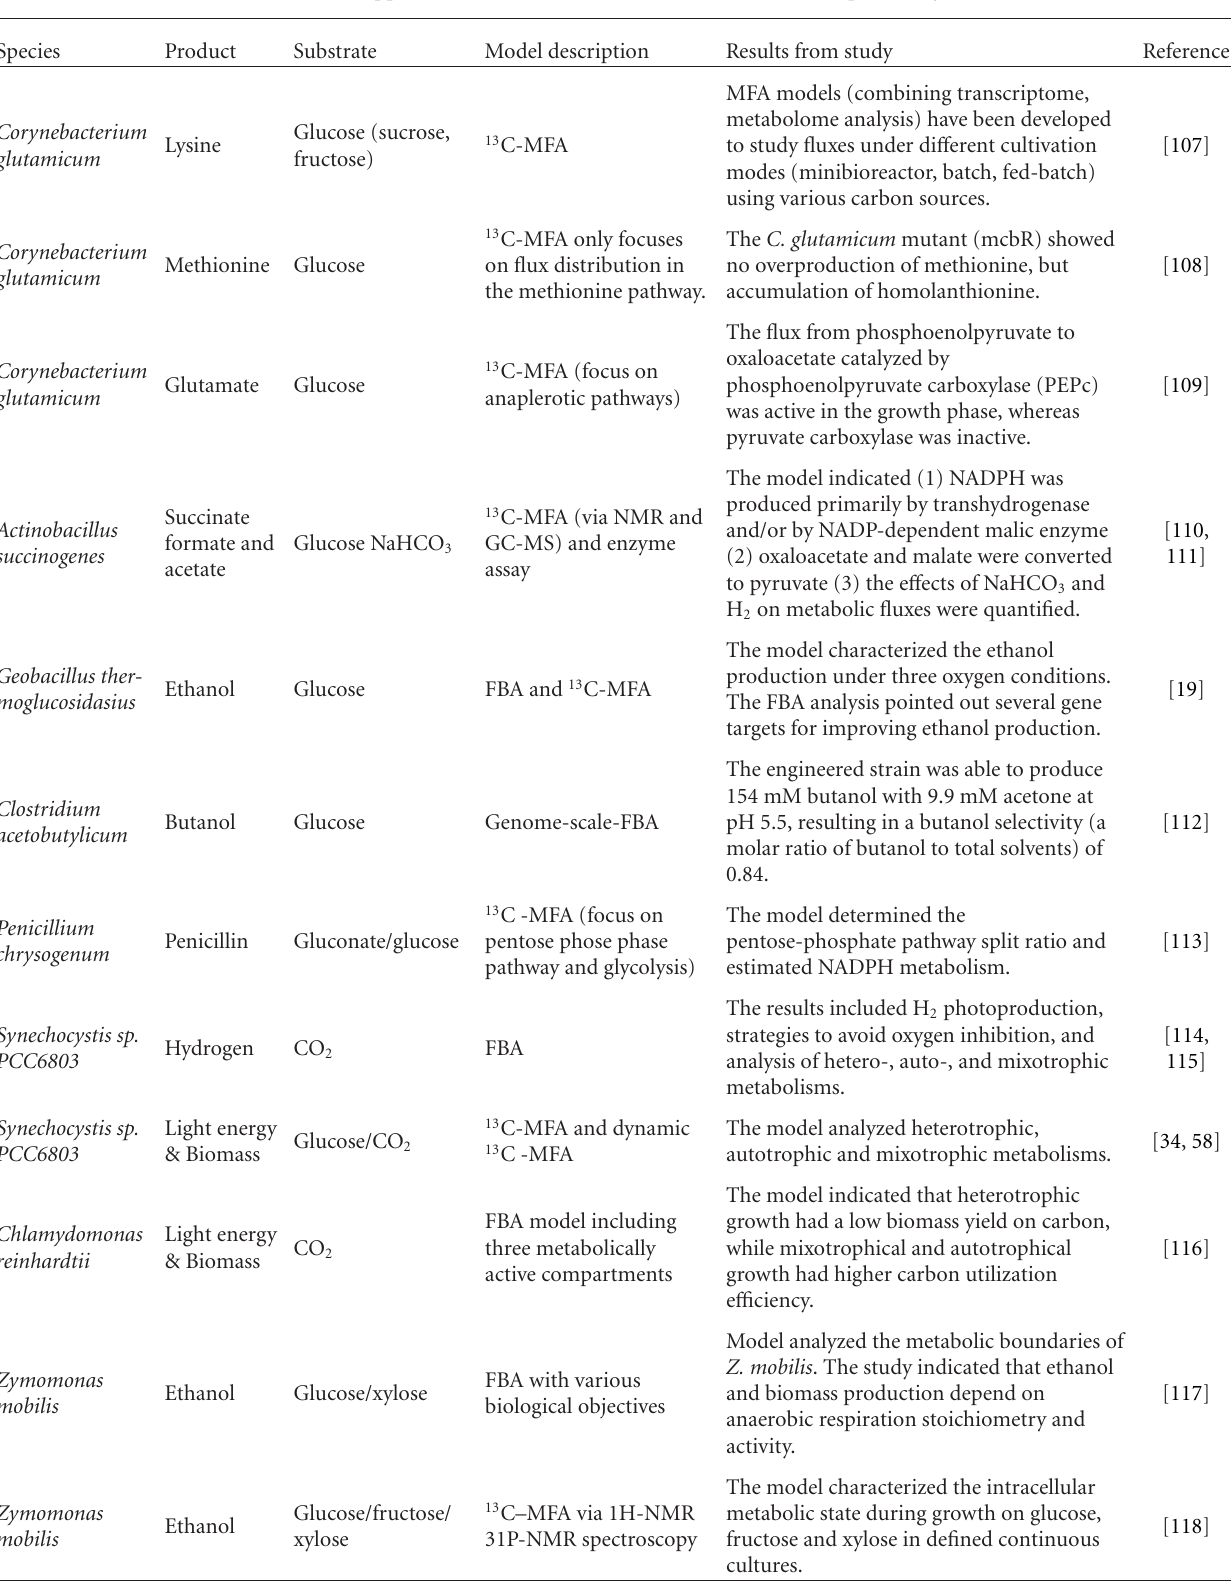
Table 1: Recent application of fluxomics of nonmodel microbes to bioproduct